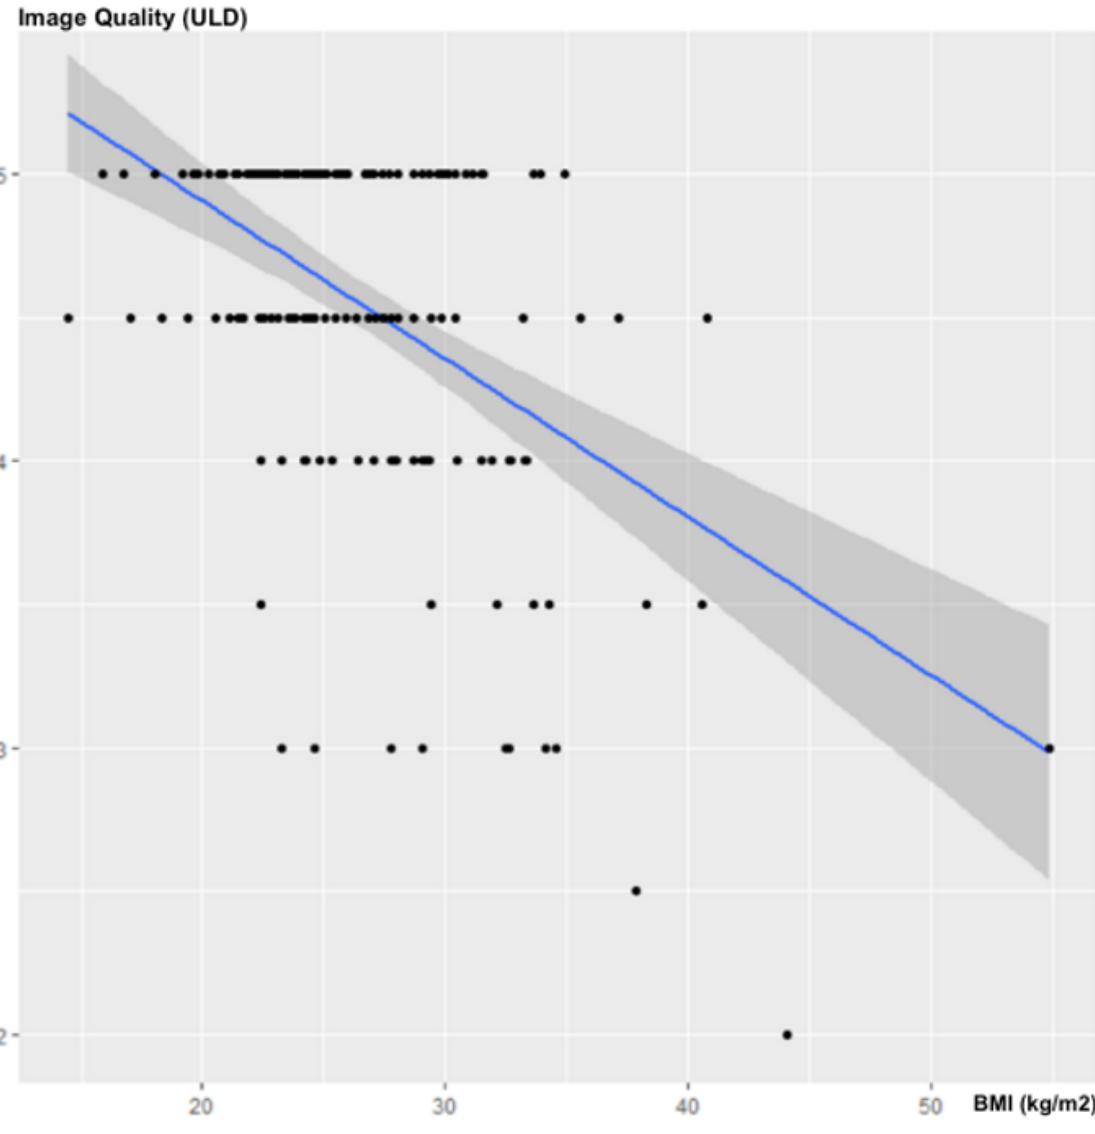
Figure 4. Influence of the BMI on subjective image quality.